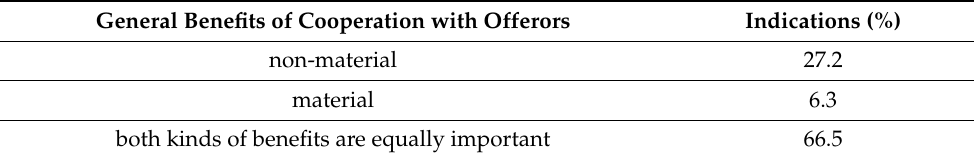
Table 2. General benefits of cooperation with offerors chosen by the respondents as more important (%).